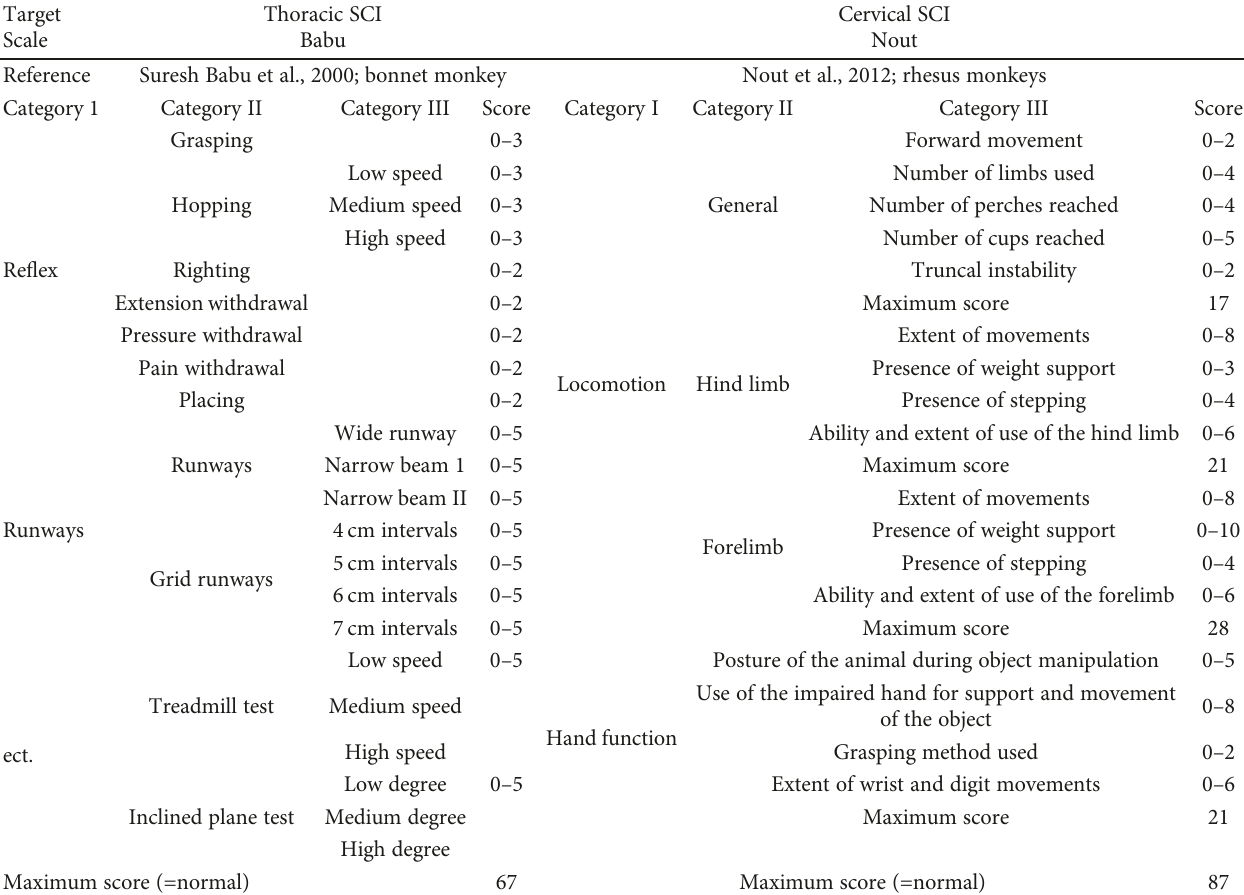
Table 3: Primate models of spinal cord injury (SCI) and suitable test